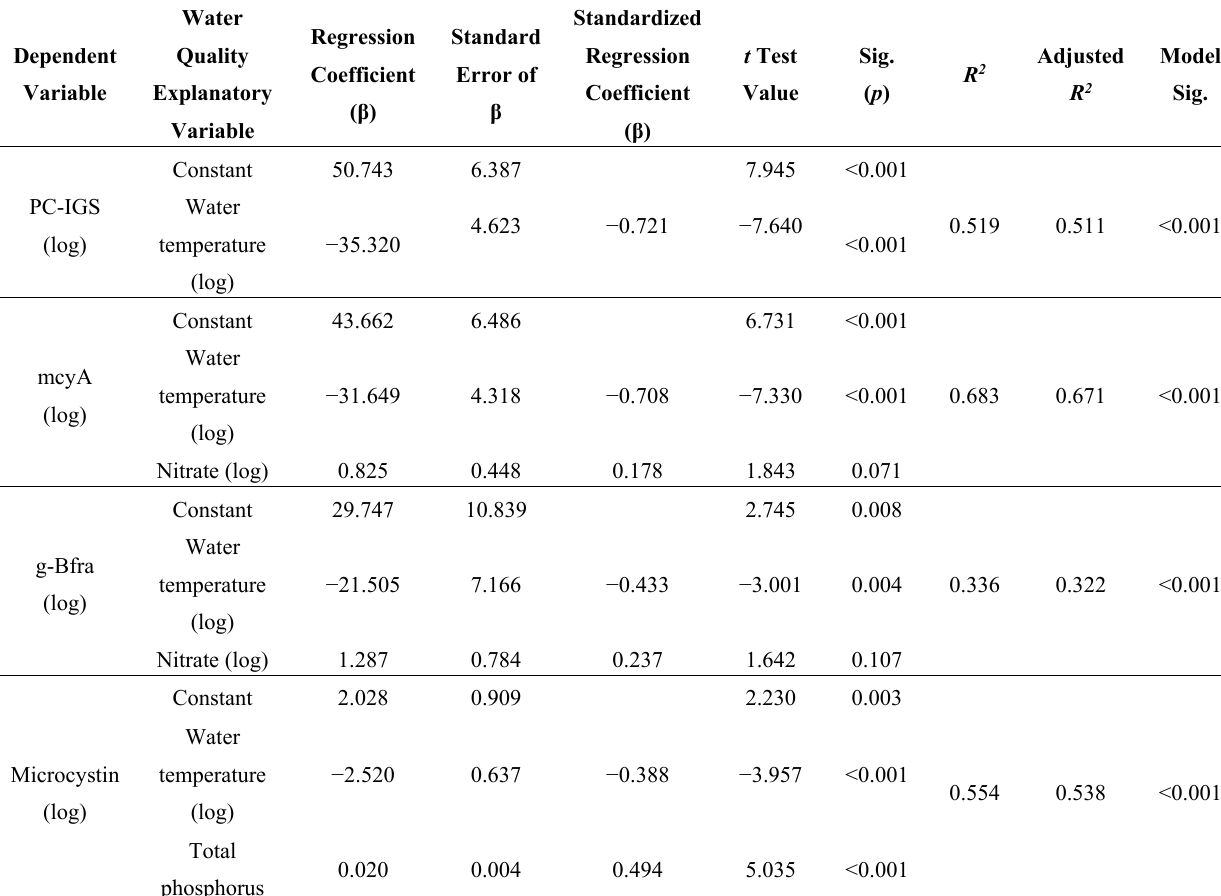
Table 4. Parameters of multiple linear regression models explaining genetic marker densities (log) and microcystin concentrations (log) from beach water